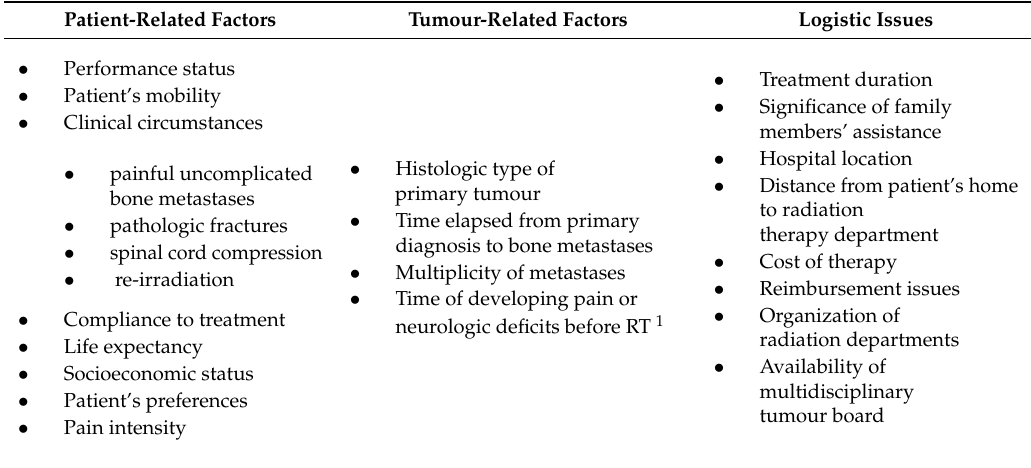
Figure 2. Isodose distribution in three-dimensional conformal radiation therapy (3D-CRT) for painful metastasis in dorsal vertebra: ( A ) one beam, ( B ) two oblique beams, ( C ) volumetrically modulated arch therapy (VMAT). Table 1. Factors influencing the radiation technique and fractionation schemes in the treatment of painful bone metastases in clinical practice.